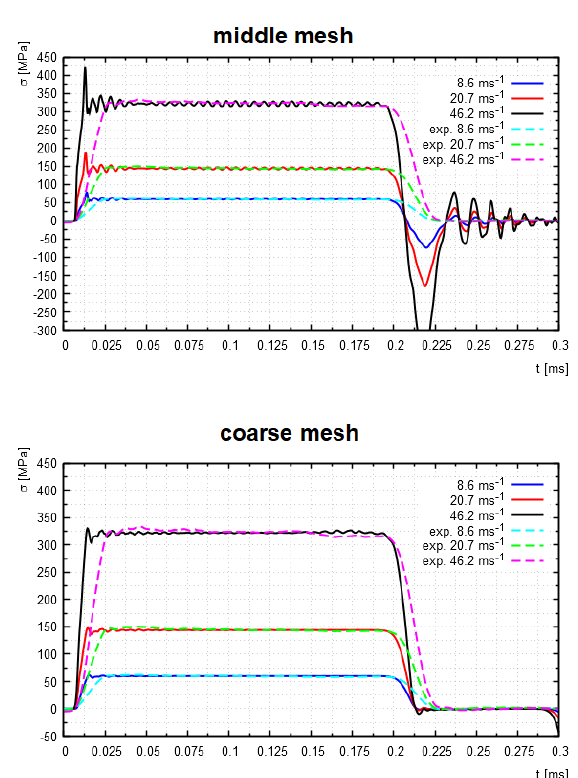
Figure 8. Comparison of experiment data with the middle (top) and the rough (bottom) meshed